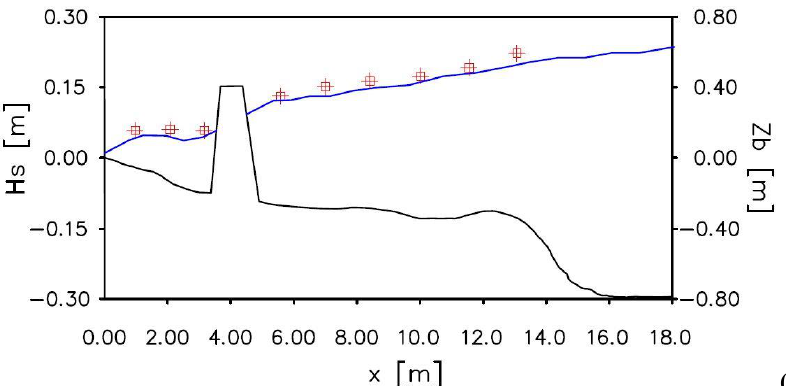
Figure 5. Significant wave height: ( a ) section at y = 22 m , ( b ) section at y = 26 m . Comparison between experimental data by Gravens and Wang [22] (red square) and numerical results (blue line). Bottom profile in black.